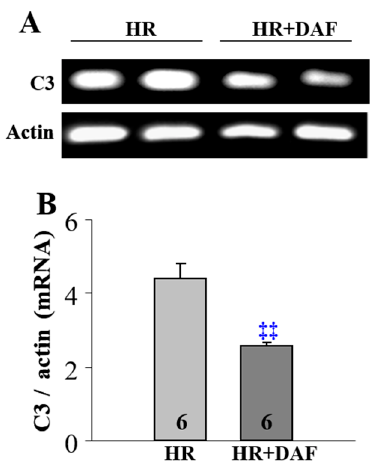
Figure 4. DAF treatment reduces pulmonary C3 mRNA synthesis in rats with hemorrhagic shock. Representative C3 mRNA expression ( A ) and quantitative expression of C3 mRNA ( B ) in the lungs. The number (6) in the figure marks the number of samples. ‡‡ p < 0.01 vs. HR (unpaired t -test with Welch’s correction).